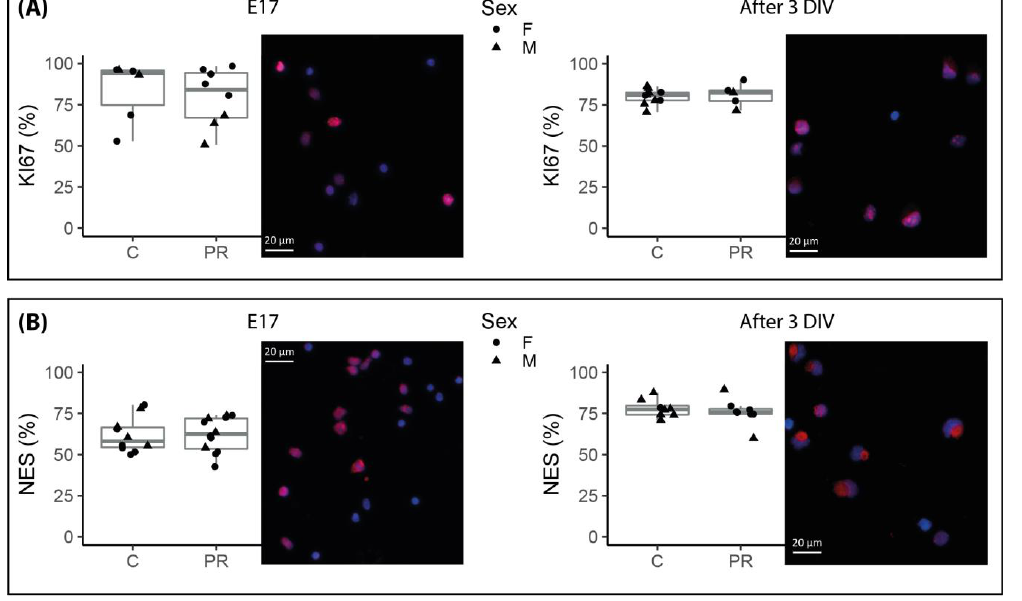
Figure 2. Neural cell type proportions in total hypothalamic cells sampled at E17 and after three days in vitro (3 DIV) labelled by immunocytochemistry and automatically counted on microscopy images. Each marker is illustrated by images obtained by optical microscopy (scale bars, 20 µm). Red and orange labelling is for markers of interest, Ki67 ( A ), Nestin ( B ), TUJ1 = TUBB3 ( C ) and MAP2 ( D ) and nucleus are labelled with DAPI in blue ( n = 6–13 per group). Group and sex effects were tested using two-way ANOVA, *group effect p = 0.02. Non-significant p values are not mentioned. (boxplot: median, first and third quartiles).